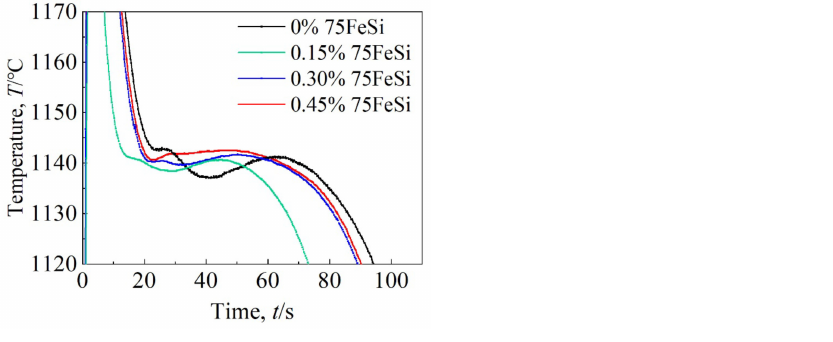
Figure 9. Eutectic sections of cooling curves with different amounts of FeSi75